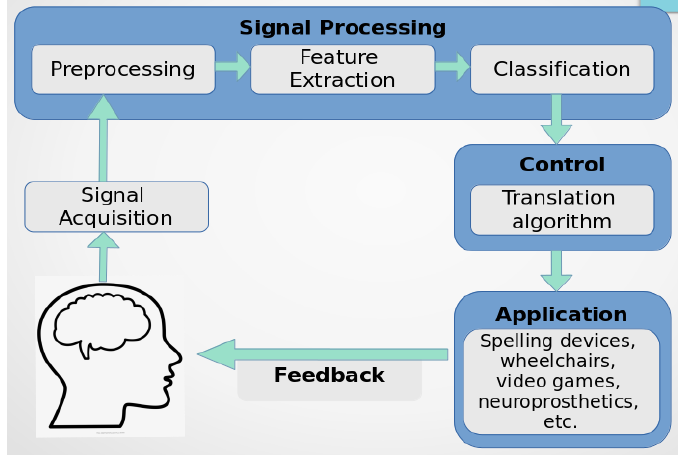
Figure 4. Architecture of a Brain Computer Interface.